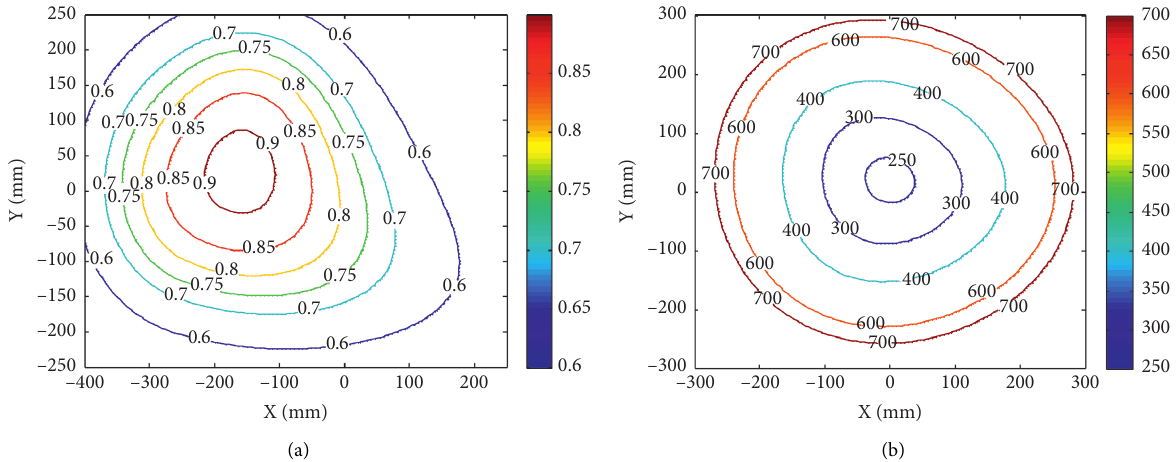
Figure 7: Distribution of the multiobjective functions by fixing the orientation angle (2.52 ° , 0 ° , 0 ° ). (a) Transmission index. (b) Condition number.